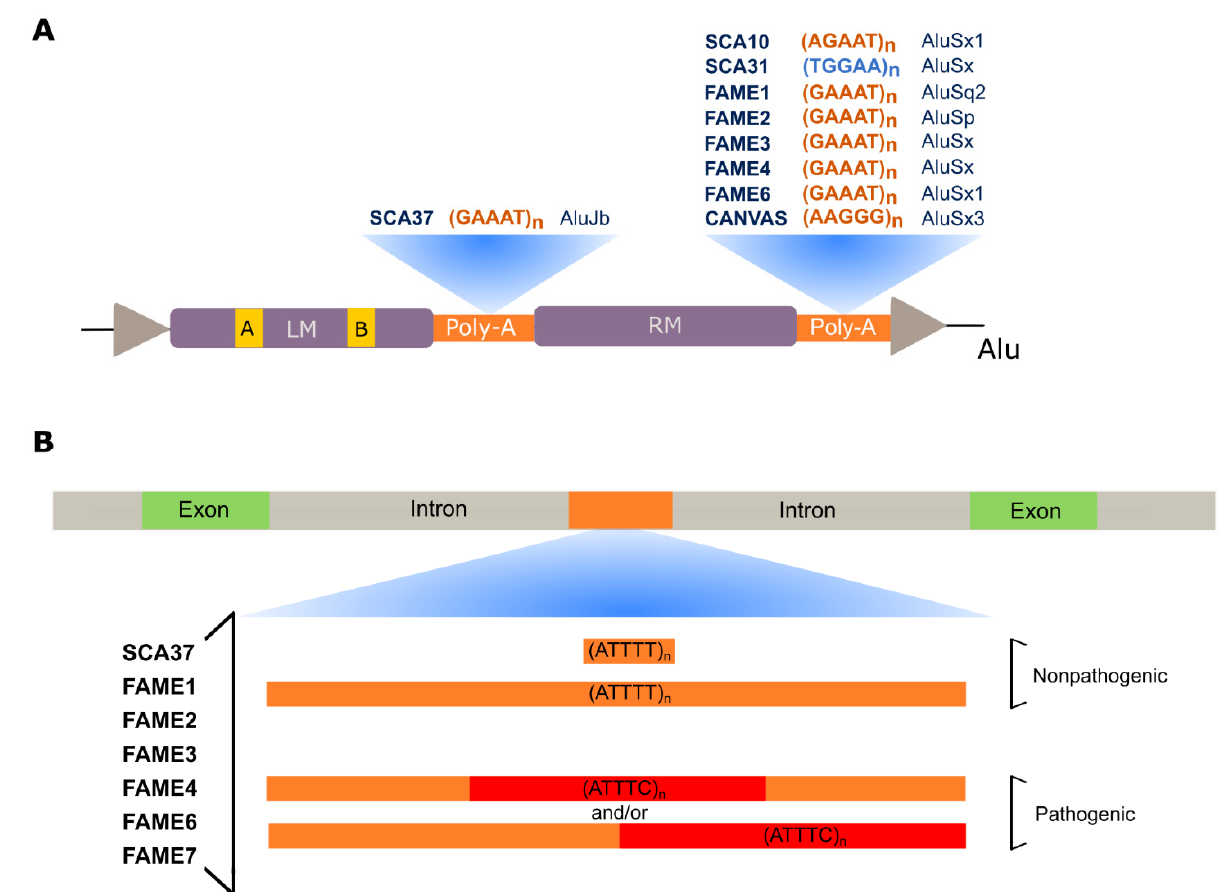
Figure 3. Pathogenic pentanucleotide repeats. ( A ) Schematic representation of pathogenic pentanucleotide repeats located in poly-A regions of ancient Alu families. Repeats are represented in Alu orientation; orange for repeats in genes with the Alu in antisense DNA strand; blue for repeats with Alu in shared introns of genes transcribed in opposite directions. The SCA37 repeat is located in the middle poly-A of an AluJb and the remaining are in 3 ′ poly-A tails of AluS elements. LM—left Alu monomer; RM—right Alu monomer; boxes A and B—internal regions of an RNA pol III promoter degenerated in ancient Alu families. ( B ) Schematic representation of non-pathogenic and pathogenic alleles with ATTTC repeat insertions, in intronic gene regions. Orange represents repeat composition of non-pathogenic alleles, whereas red is the pathogenic repeat insertion. Most non-pathogenic chromosomes have less than 30 repeats, but some can be larger than the pathogenic tract.